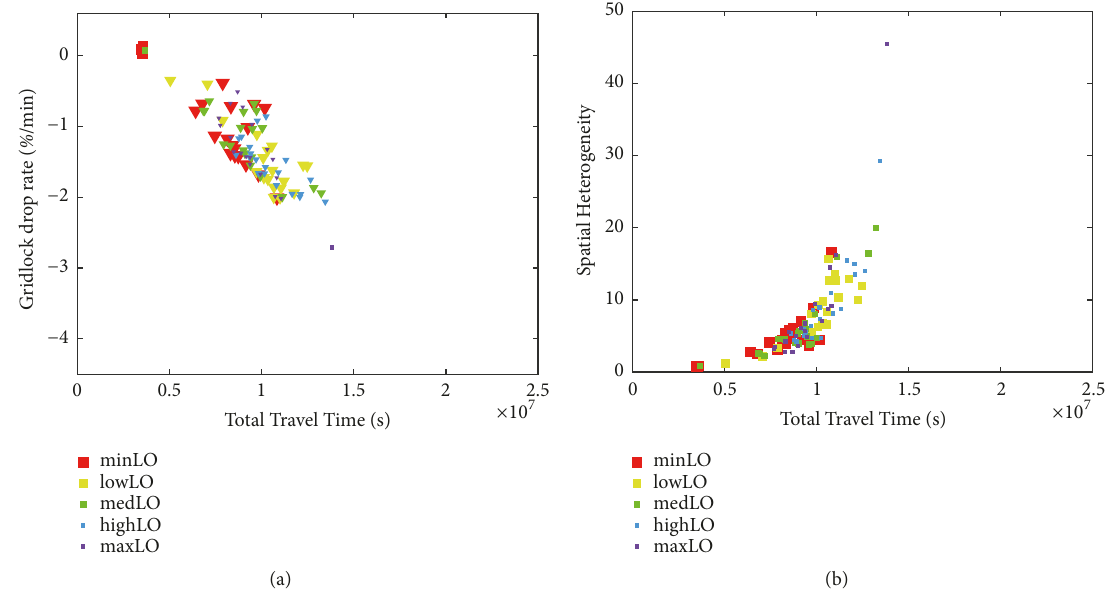
Figure 14: Network heterogeneities with demand level 5 and dynamic assignment, colored by local overlapping level. (a) Gridlock drop rate and (b) spatial heterogeneity.